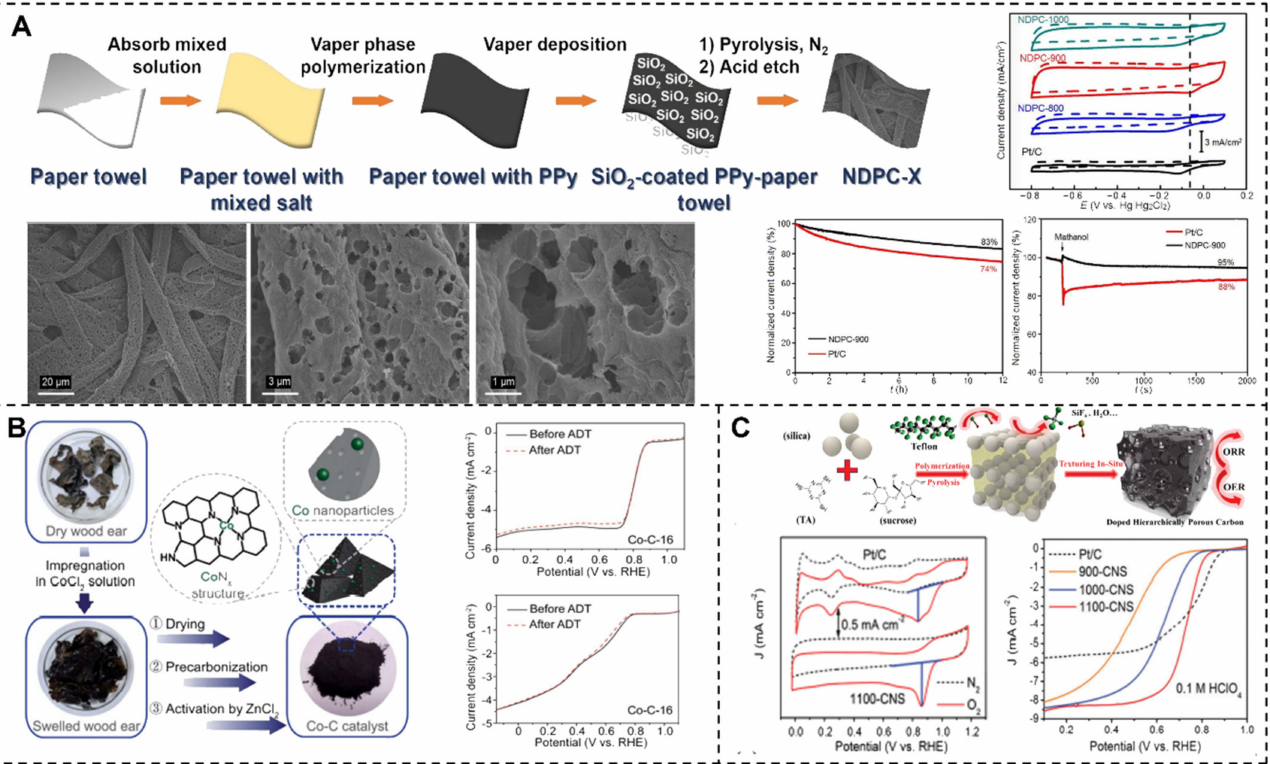
Figure 1. ( A ) Synthesis principle scheme, SEM images and electrochemical performance of NDPC-900 catalyst [15]; ( B ) Schematic diagram of Co-C catalyst preparation using wood ear as a precursor and durability test of catalyst [16]; ( C ) Diagram of the one-pot preparation process of doped porous carbon materials and CV, LSV curves of the Pt/C and the metal free samples catalyst